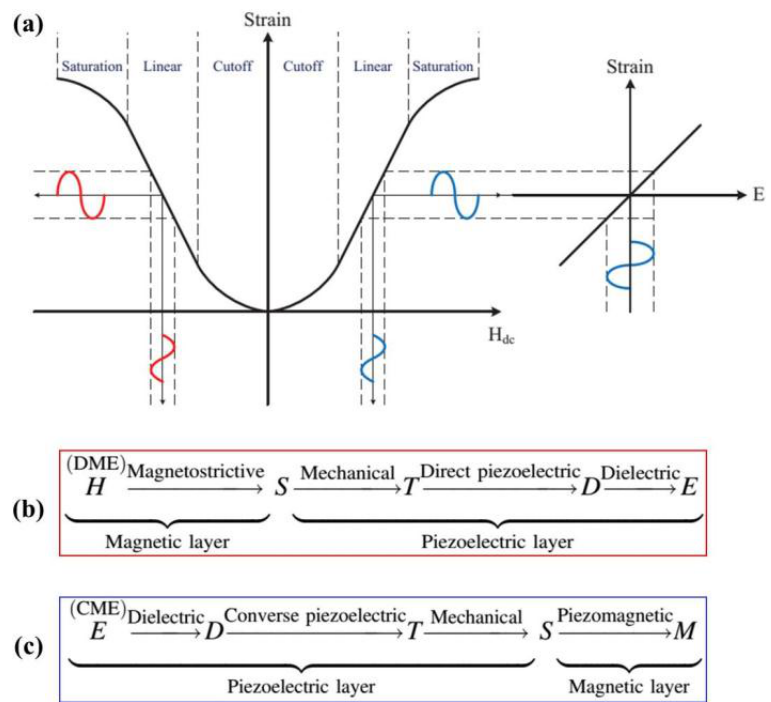
Figure 2. Schematic representation of the ( a ) ME effect utilizing the product property (Adapted from [6]). ( b ) DME effect and ( c ) CME effect in composites [7]. Here, H is magnetic field, S is mechanical strain, T is mechanical stress, D is electric displacement, E is electric field, and M is